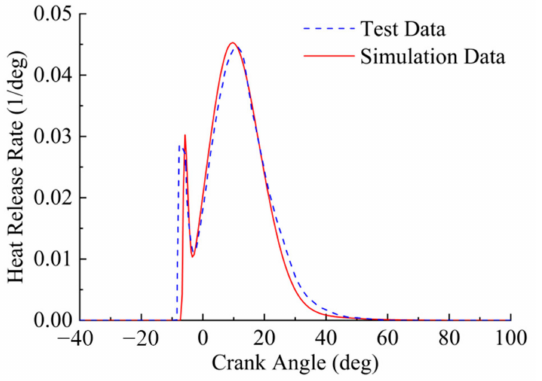
Figure 3. Comparison of heat release rate.